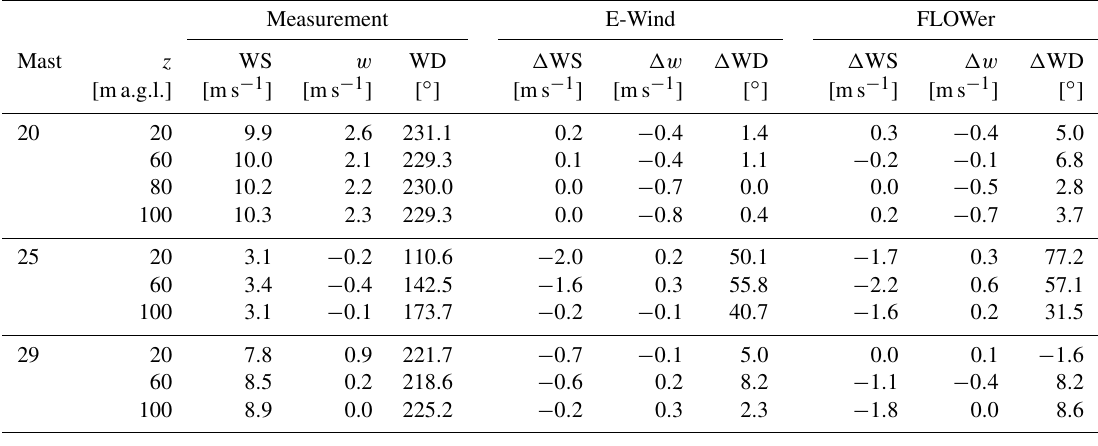
Table 3. Comparison of E-Wind result and FLOWer result (180s averaged) with met mast data (30min averaged). Measurement E-Wind